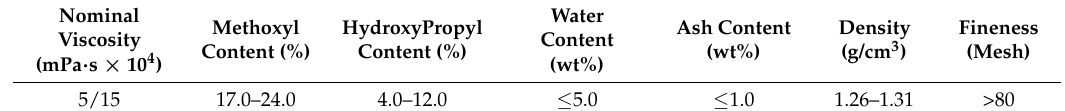
Table 5. Performance indexes of